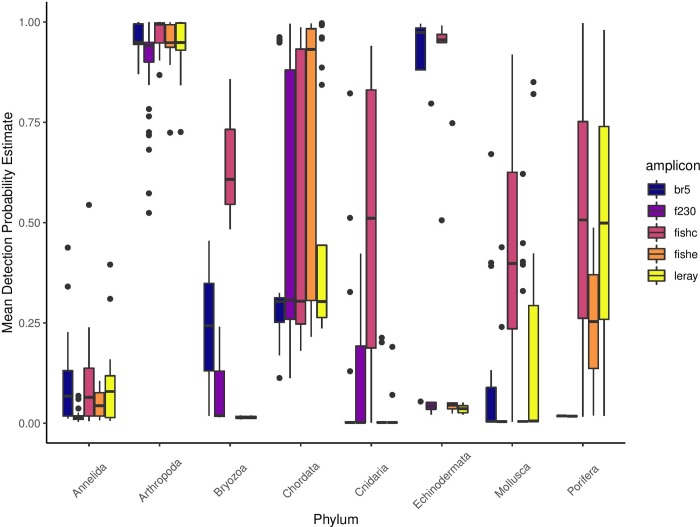
Mean detection probability estimated from occupancy model 9 (ψ(.) ϴ(.) p(amplicon)) for each species plotted by amplicon and phylum for metazoan phyla only.The band in the middle of the box represents the median and the upper and lower edges of the box represent the upper and lower quartiles. The whiskers represent 1.5 times the inter-quartile range.